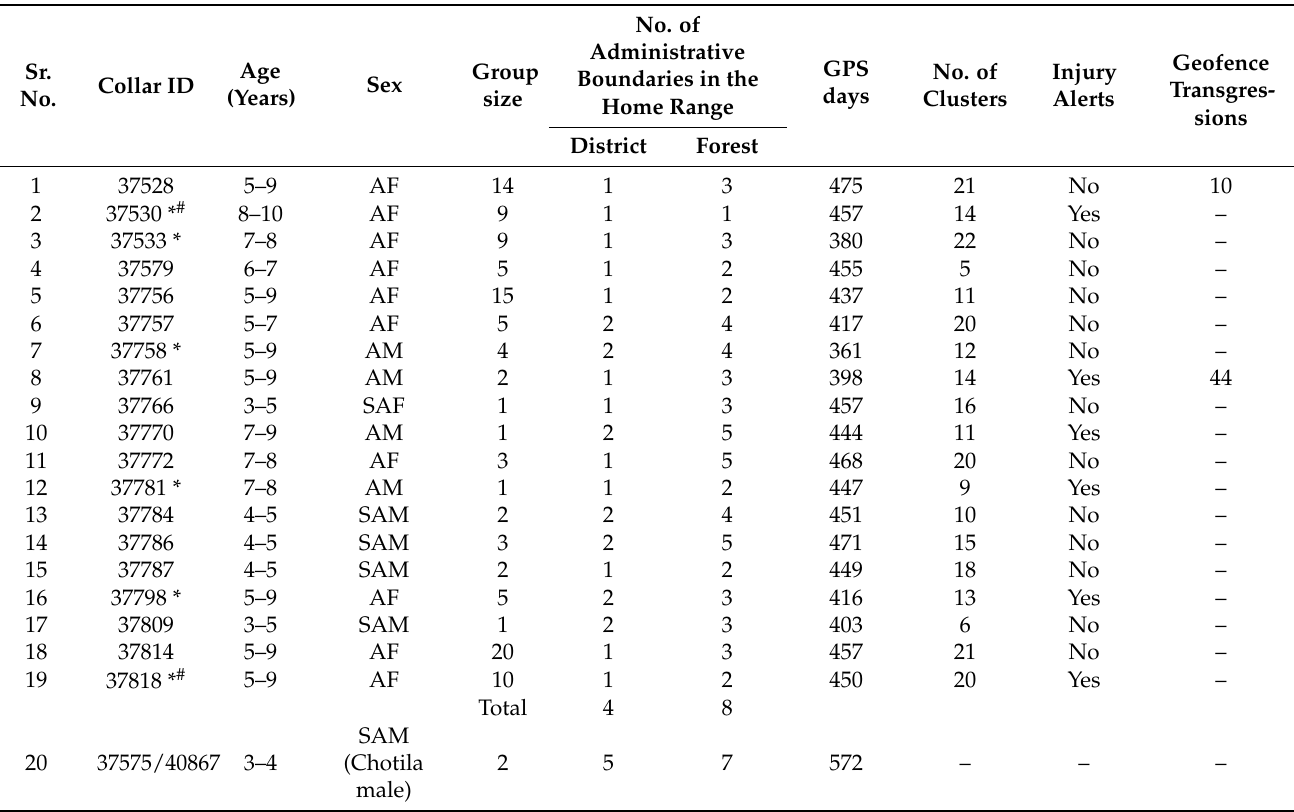
Table 1. The summary of demographic characteristics, monitoring, and the cluster of GPS